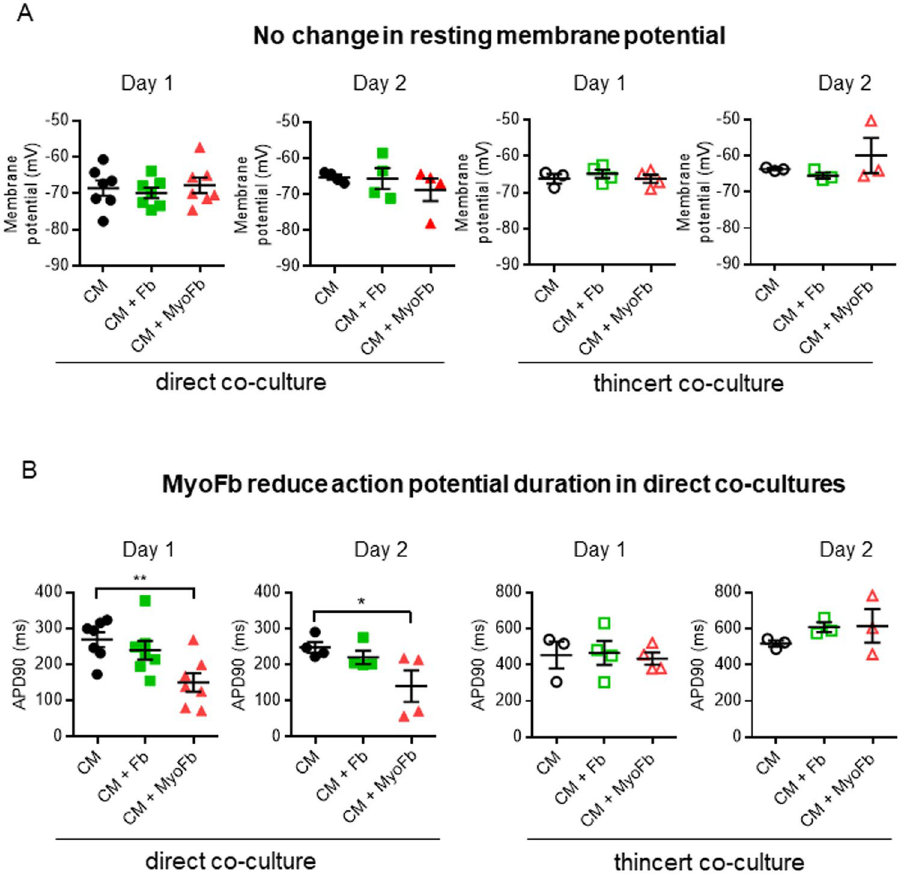
Figure 4. Modulation of the membrane potential of CMs by MyoFbs. ( A ) Resting membrane potential. ( B ) Action potential duration at 90% repolarization (APD 90 ). CMs in direct and indirect (thincert) co-culture with Fbs or MyoFbs. (n cells = 10–35; N culture = 3–7; 1-way ANOVA with Bonferroni post hoc test, ** p = 0.006, * =